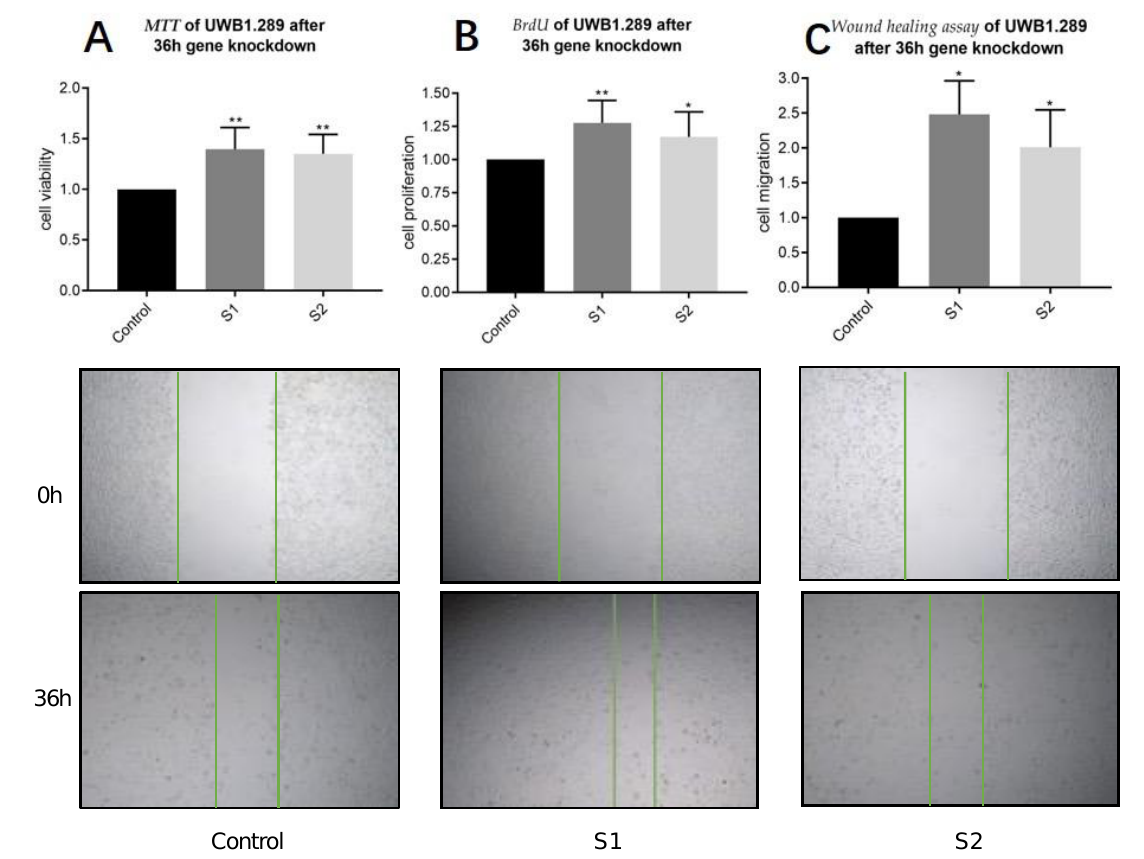
Figure 5. PLA2G7 silencing favored cancer progression by an activation of viability, proliferation, and migration. MTT results show that after 36 h siRNA (sequence S1 and S2) knockdown of PLA2G7, the viability of UWB1.289 increased significantly (( A ); p < 0.001). DNA incorporation of BrdU was also significantly higher in the PLA2G7 downregulated group, indicating an increasing proliferation rate ( B ). The wound healing assay proved that the migration ability of PLA2G7-downregulated UWB1.289 cells was significantly activated compared to the control group (( C ); p < 0.05). Significant results are indicated by asterisks (*: p ≤ 0.05) and double asterisks (**: p ≤ 0.001).